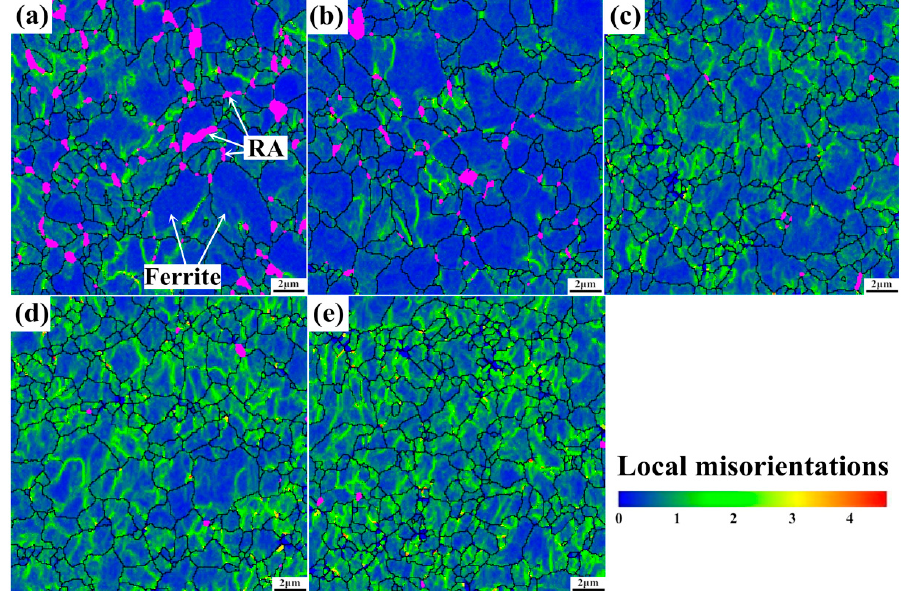
Figure 9. Local misorientation distribution maps of BCC phase of tensile tested specimens with different strain level: ( a ) 0%, ( b ) 5%, ( c ) 10%, ( d ) 15%, and ( e ) 20% (BCC grain boundaries in dark solid lines and retained austenite grains in purple color areas). Materials 2018 , 11 , x FOR PEER REVIEW